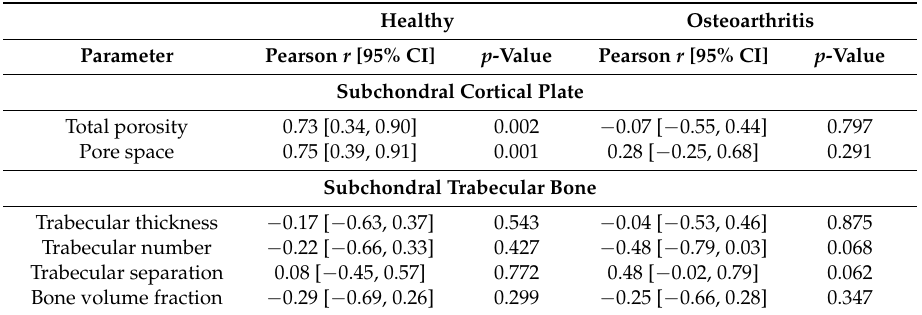
Table 3. Correlation between subchondral cortical plate thickness and bone structural